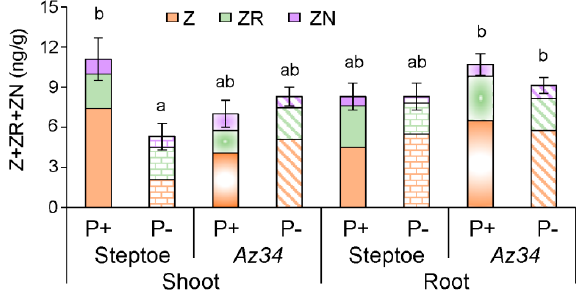
Figure 8. Sum of cytokinins (zeatin (Z), its riboside (ZR) and nucleotide (ZN)) concentration (calculated per g fresh mass) in shoots and roots of 4-days-old barley plants (cv. Steptoe and Az34 ) grown for 1 day on nutrient solutions with (P+) or without (P − ) phosphate. Bars are means ± S.E. of n = 9 for the sum of zeatin derivatives, with significant ( p ≤ 0.05) differences between all genotype / treatment combinations marked with different letters (ANOVA, LSD).